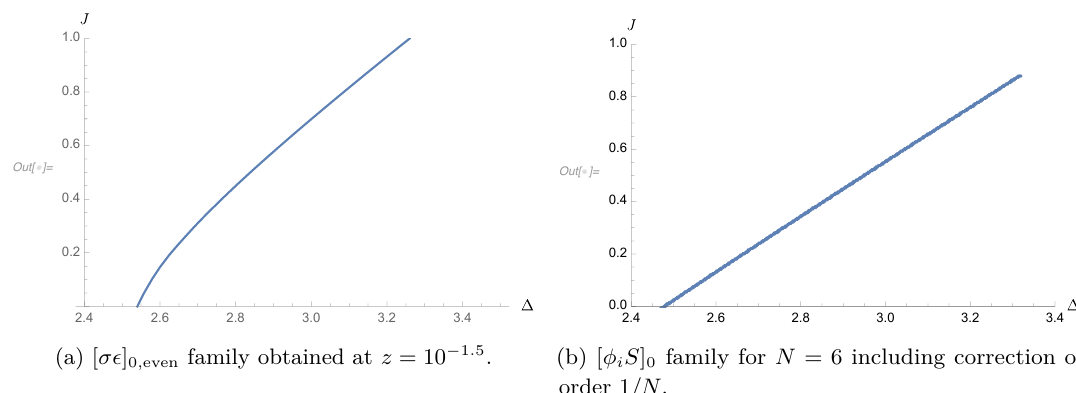
Figure 23 . Chew-Frautschi plot for leading non-singlet trajectories in the 3D Ising and O ( N ) model respectively. See figure 12 and figure 22 for similar plots of the leading singlet